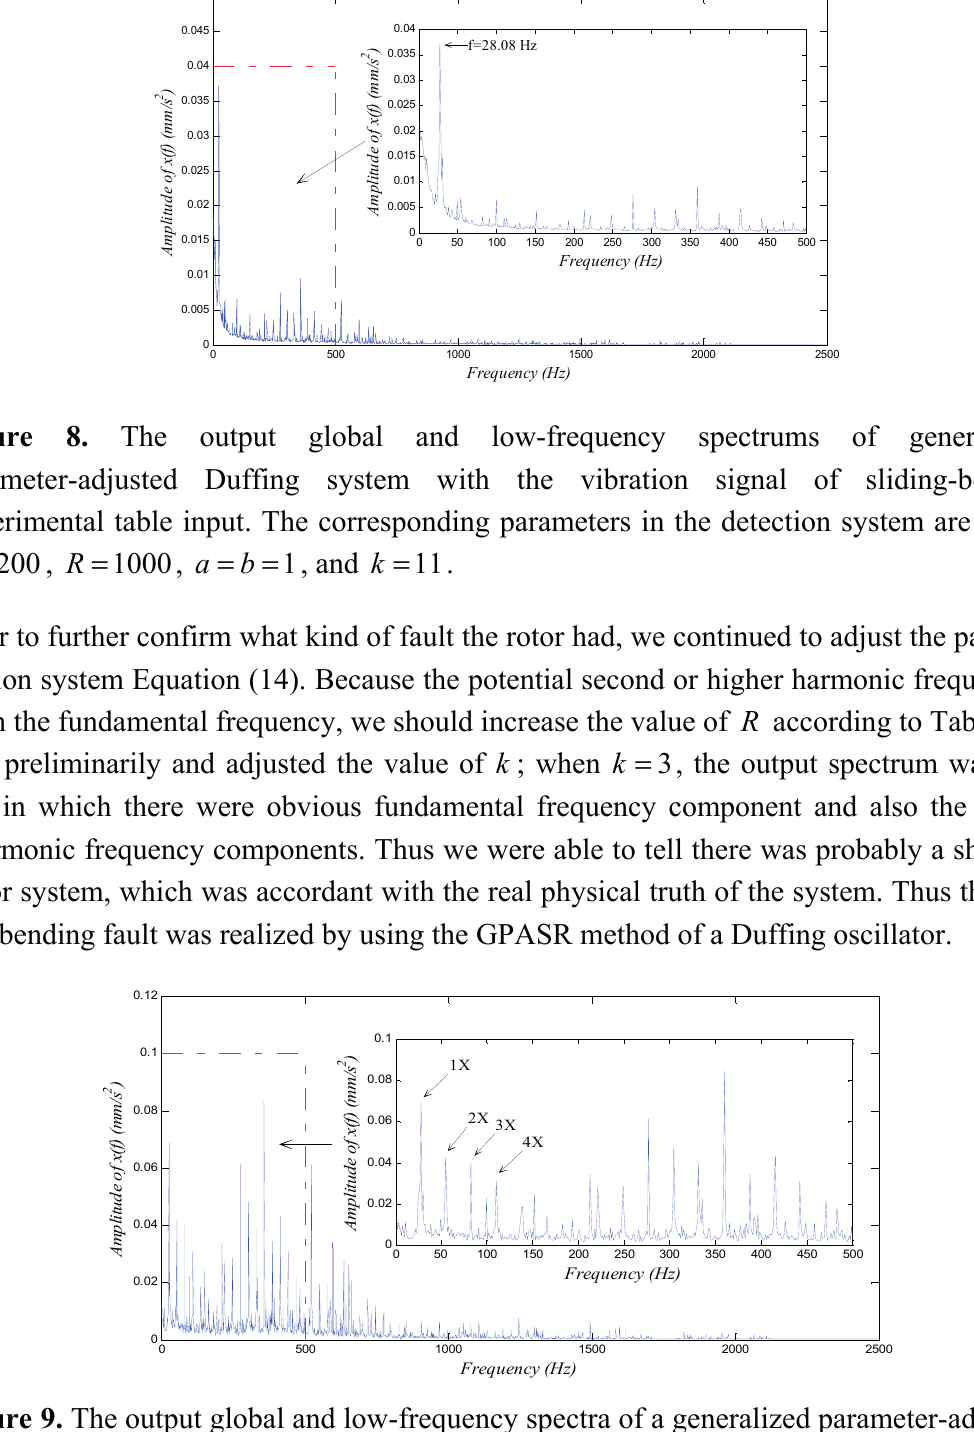
Figure 9. The output global and low-frequency spectra of a generalized parameter-adjusted Duffing system with the vibration signal of sliding-bearing experimental table input. The corresponding parameters in the detection system are set to ε